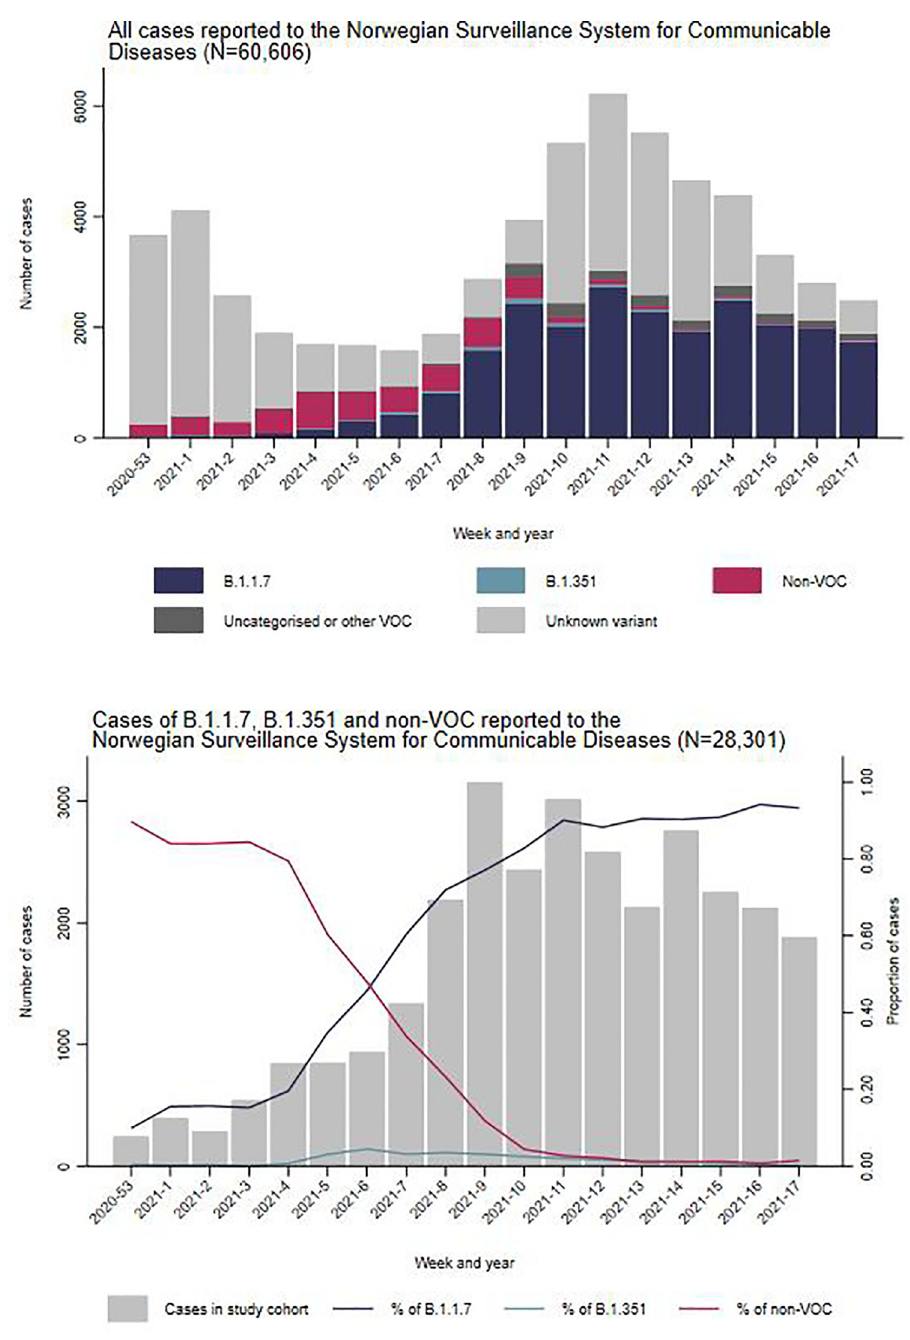
Fig 1. Distribution of COVID-19 cases reported and screened with B.1.1.7, B.1.351 and non-VOC by week of sampling, Norway, December 2020—May 2021. Note: ’ All cases reported’ (n = 60,606) excludes vaccinated cases, cases who did not have a national identity number registered and hospitalised cases who did not have COVID-19 as their main cause of admission (n = 4,434). ’Uncategorised or other variant of concern’ (VOC) includes cases of P.2 (n = 7) and B.1.617.2 (n = 12), and cases for whom B.1.1.7, B.1.351, other VOC and non-VOC could not clearly be distinguished (n = 1,659).